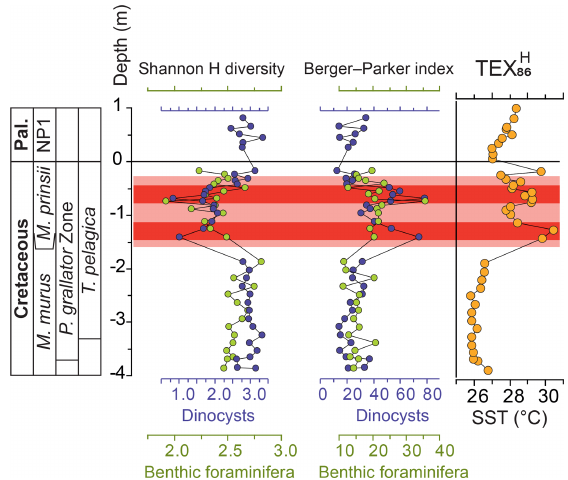
Figure 3. Overview of benthic foraminiferal and dinocyst diversity indices. TEX 86 SST record of ODP 174AX Bass River (Woelders et al., 2018) and Shannon H diversity and Berger–Parker index of the benthic foraminifera (green) and dinocysts (blue) of the Bass River core. For the raw data, see Tables S1 and S6. Pal. – Paleogene; T. pelagica – Thalassiphora pelagica ; M. – Micula